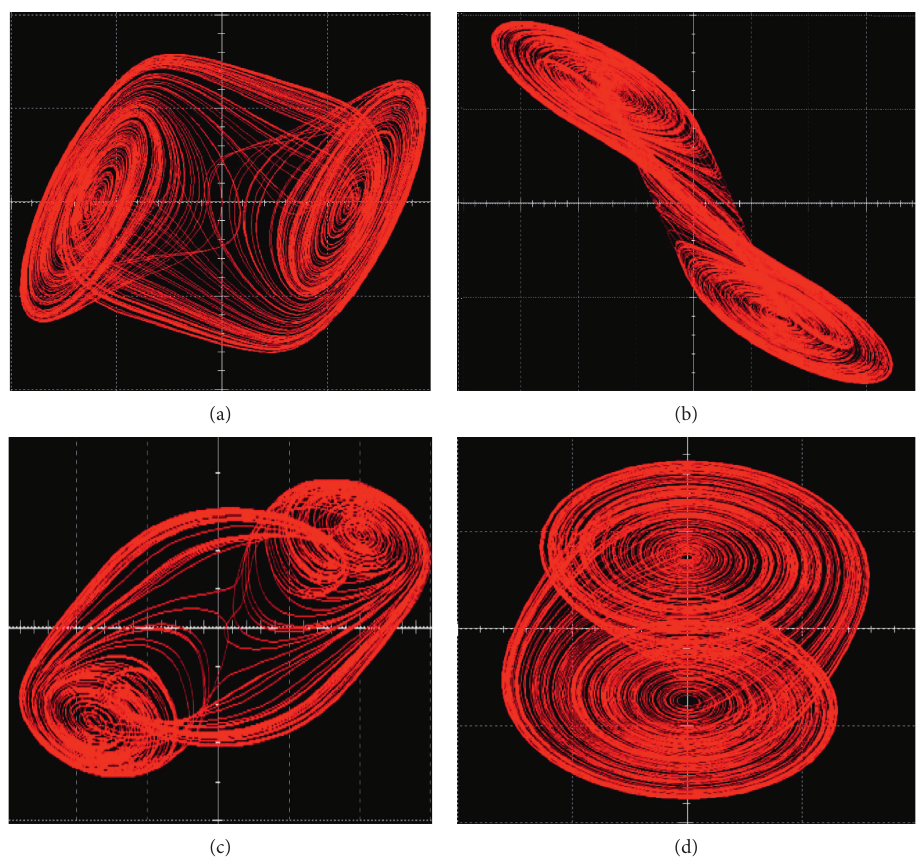
Figure 12: Multisim simulation of double-scroll phase portraits ( R � 1680 Ω ) of the inductorless modified Chua’s chaotic circuit: (a) in x –y plane, (b) in x –z plane, (c) in x –w plane, and (d) in y –z plane.